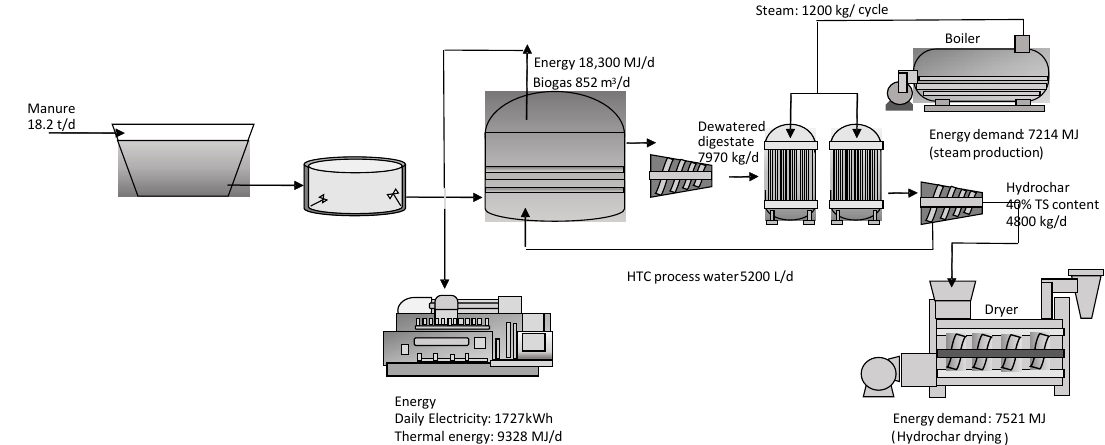
Figure 2. Representation of the main treatment stages in Scenario 1 (anaerobic digestion and subsequent HTC treatment of the whole digestate